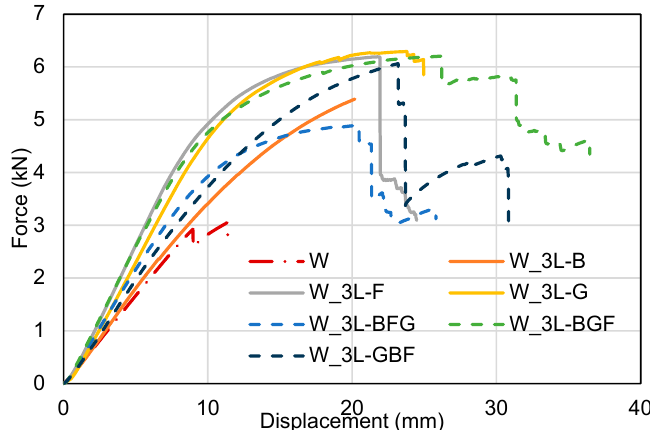
Figure 4. Load mid-span displacement curves of three-layer FRP strengthened wood beams.